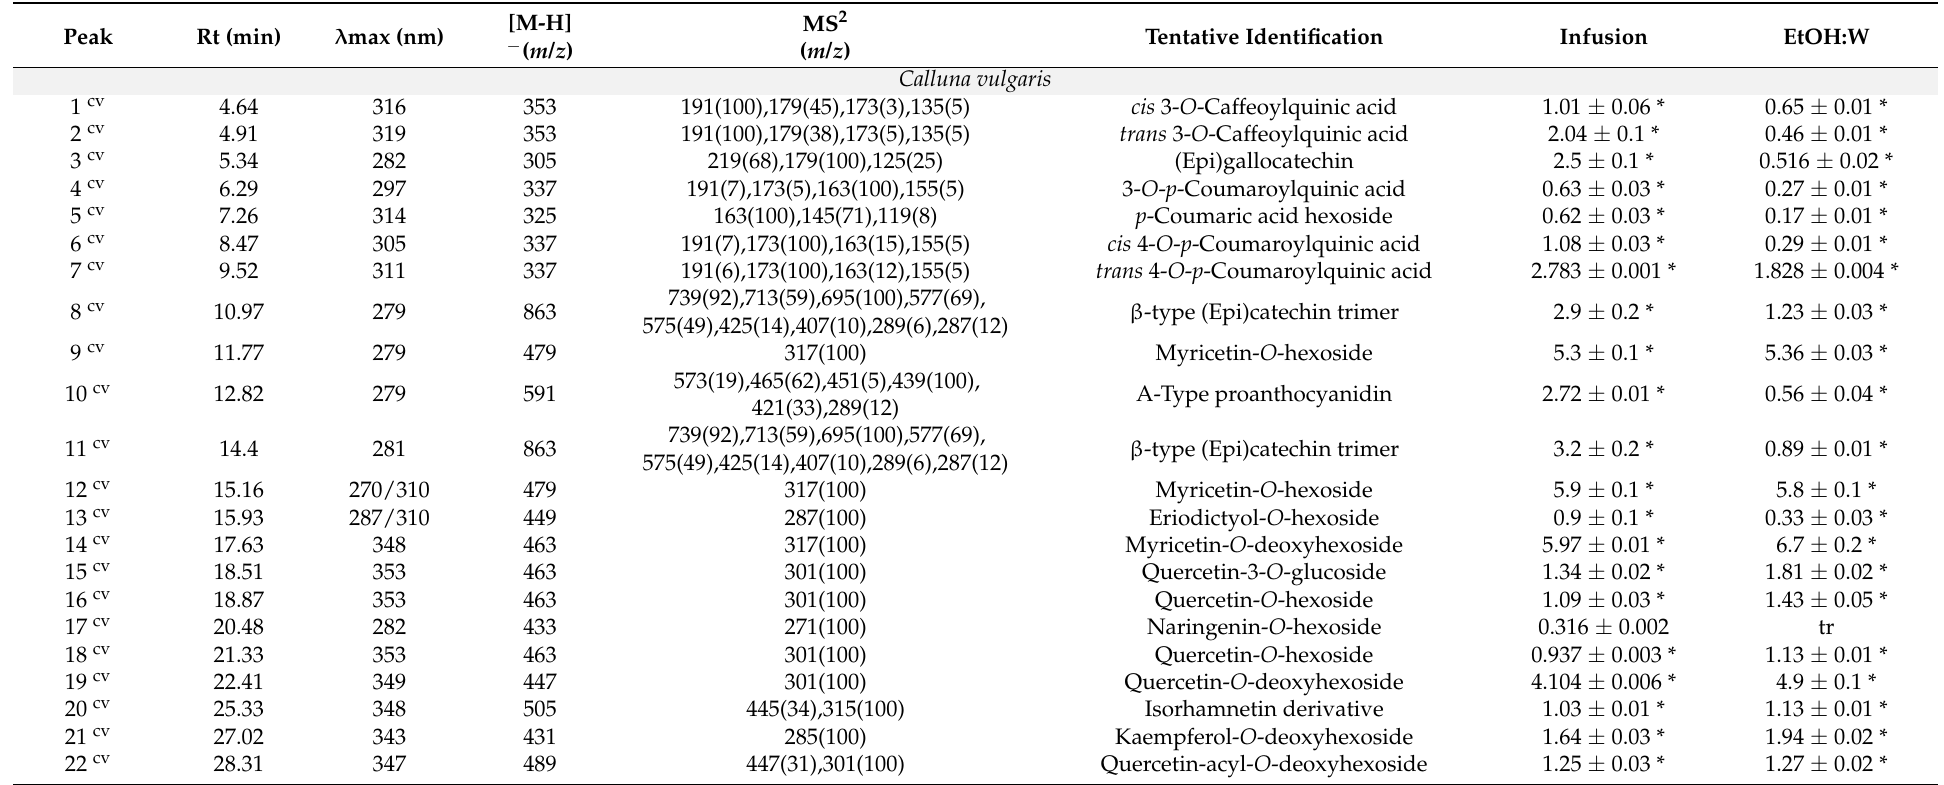
Table 1. Retention time (Rt), wavelengths of maximum absorption in the visible region ( λ max), mass spectral data, identification, and quantification (mg/g extract) of the phenolic compounds present in the hydroethanolic extracts and infusions of C. vulgaris , G. tridentata , C. multiflorus , V. sinuatum and C. edulis (Mean ± SD), and the respective extraction yield ( η ,